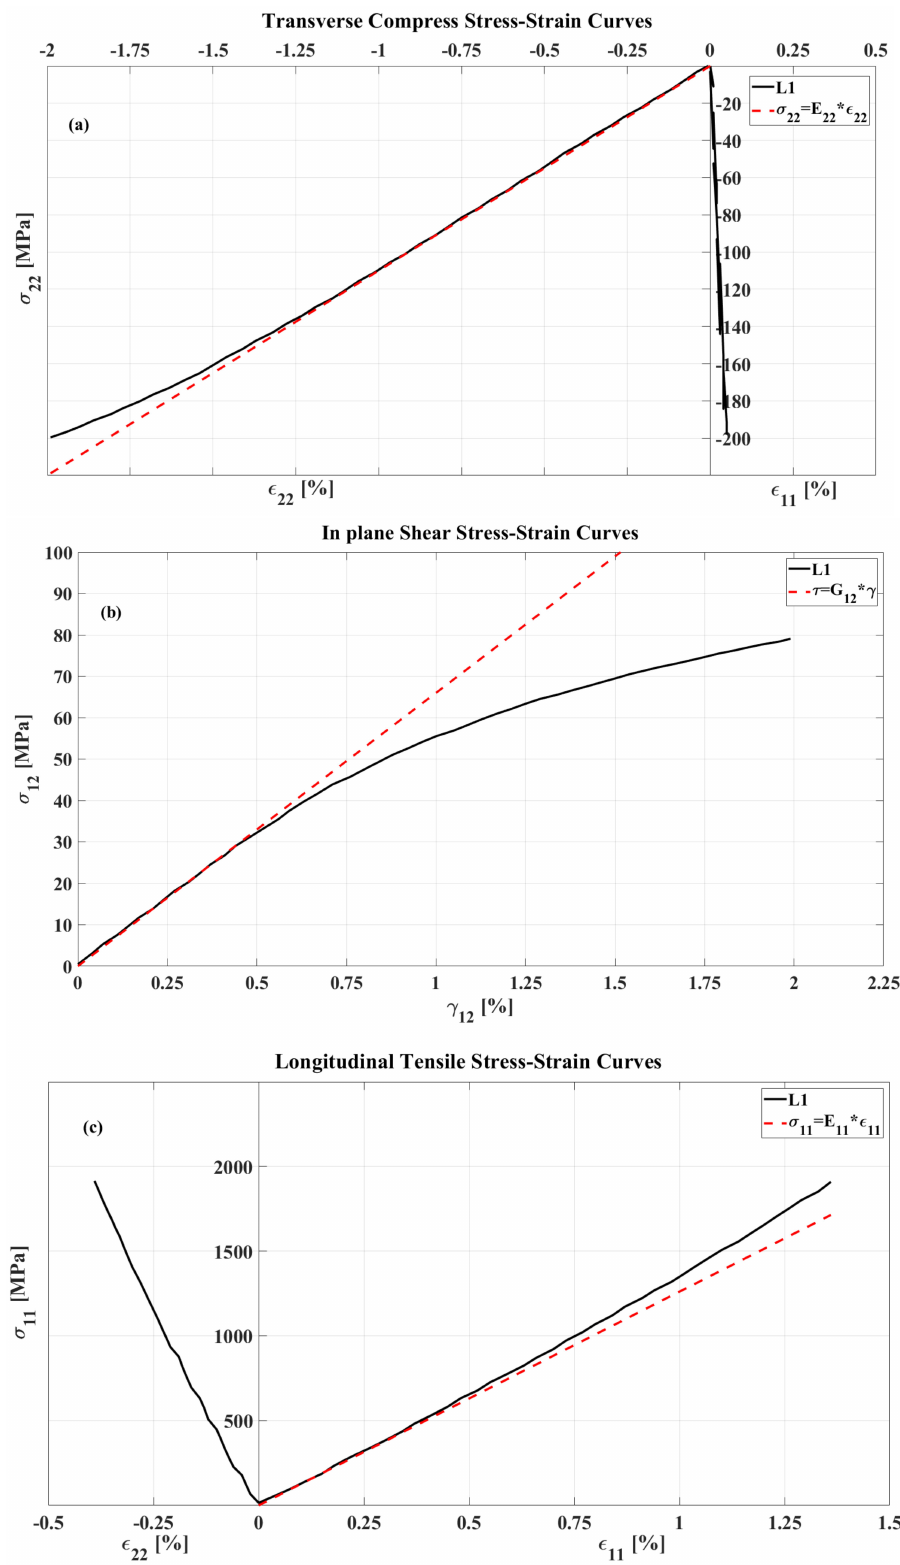
Figure 6. Composite AS4/3501-6: ( a ) longitudinal tensile/compression test along 11 directions; no linear behavior on tensile; ( b ) transverse tensile/compressive stress along 22 directions; ( c ) plane shear test on plane 12. Linear behavior is indicated by γ 12 < 0.5%, whereas γ 12 > 0.5% composite indicates nonlinear